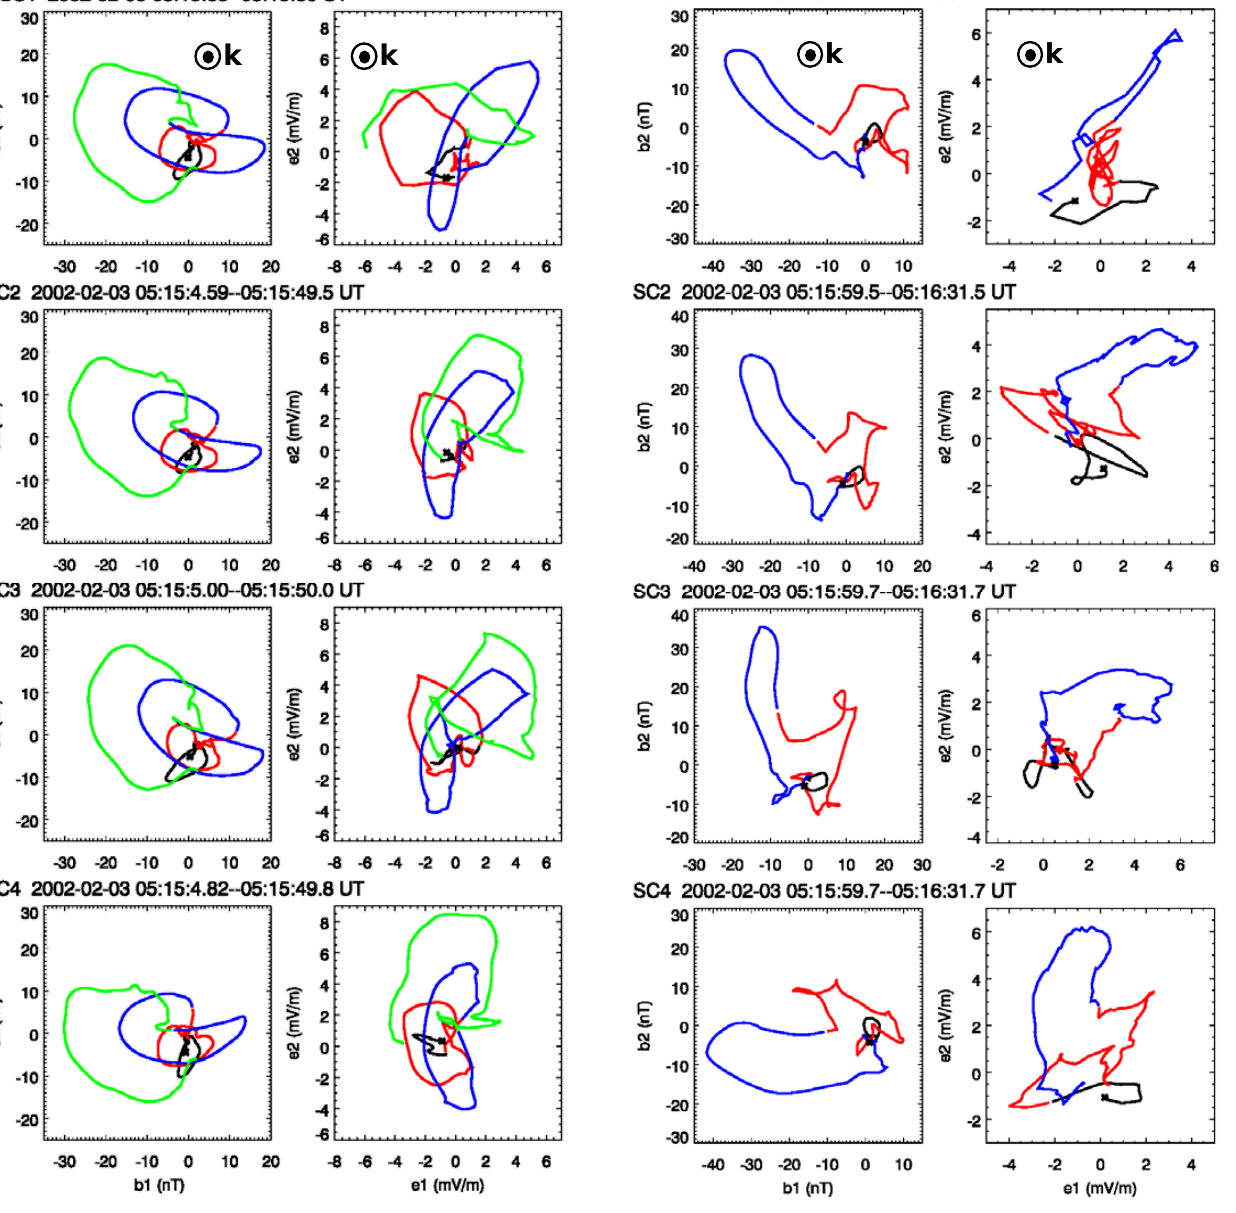
Fig. 3b. The same as Fig. 3a but for interval